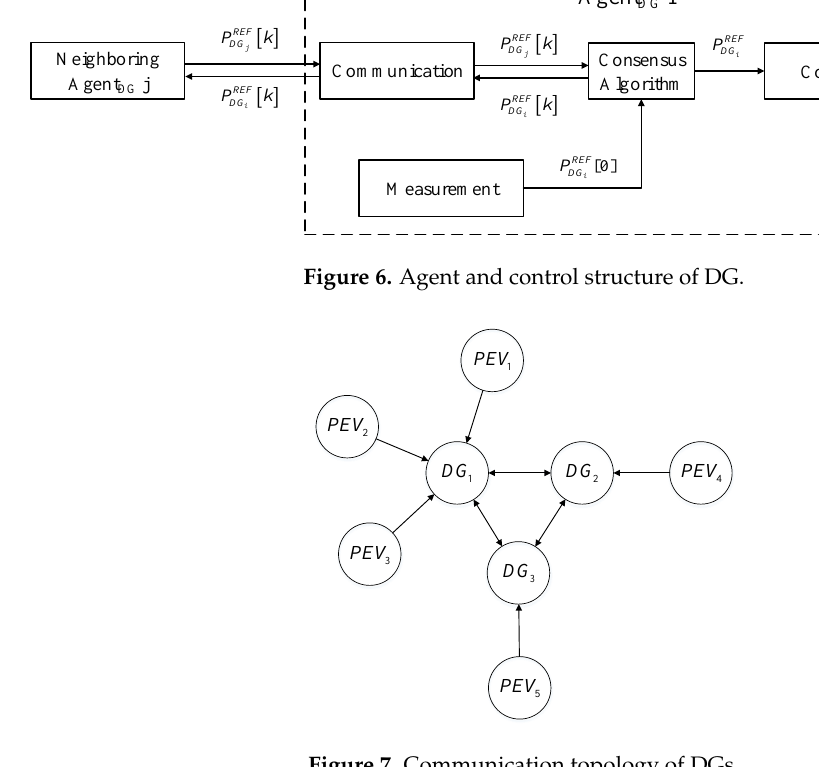
Figure 7. Communication topology of DGs.